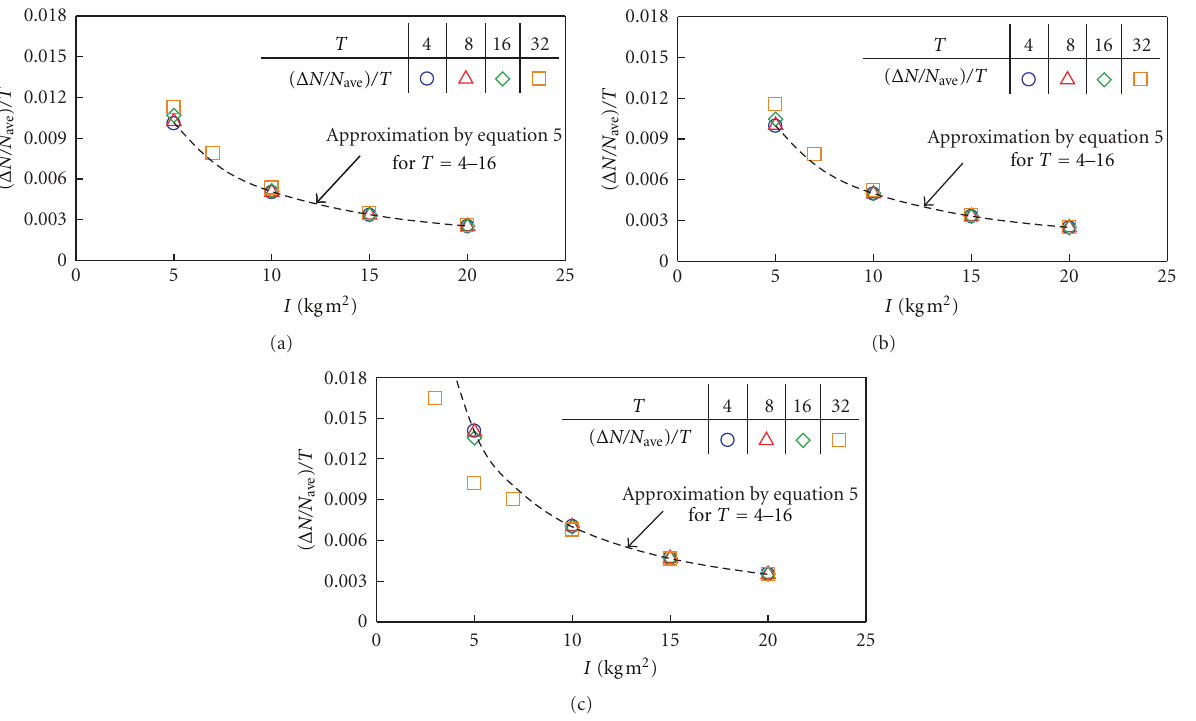
Figure 16: Rate of change of rotational speed divided by wind cycle, ( Δ N/N ave ) /T , for mean wind speed (a) V 0 = 7, (b) V 0 = 10, and (c) V 0 = 13m/s.